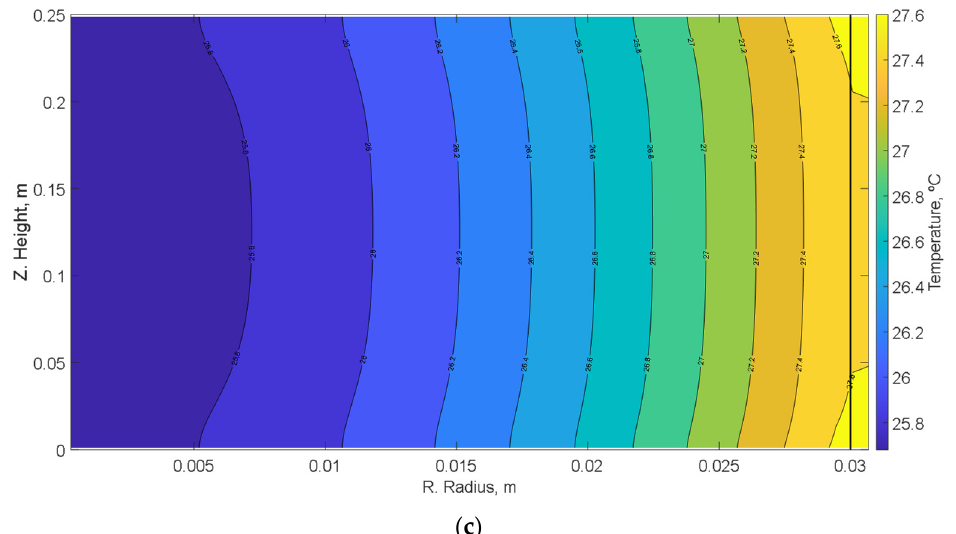
Figure 11. Distribution of temperatures for each of the materials at one hour and an ambient temperature of 30 °C. ( a ) Al319, ( b ) PET, and ( c ) PP.